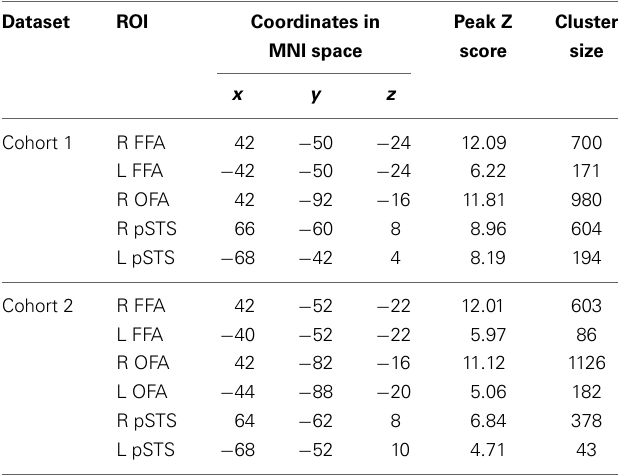
Table 1 | Coordinates of peak voxels and cluster sizes of the face-selective regions from the group-level